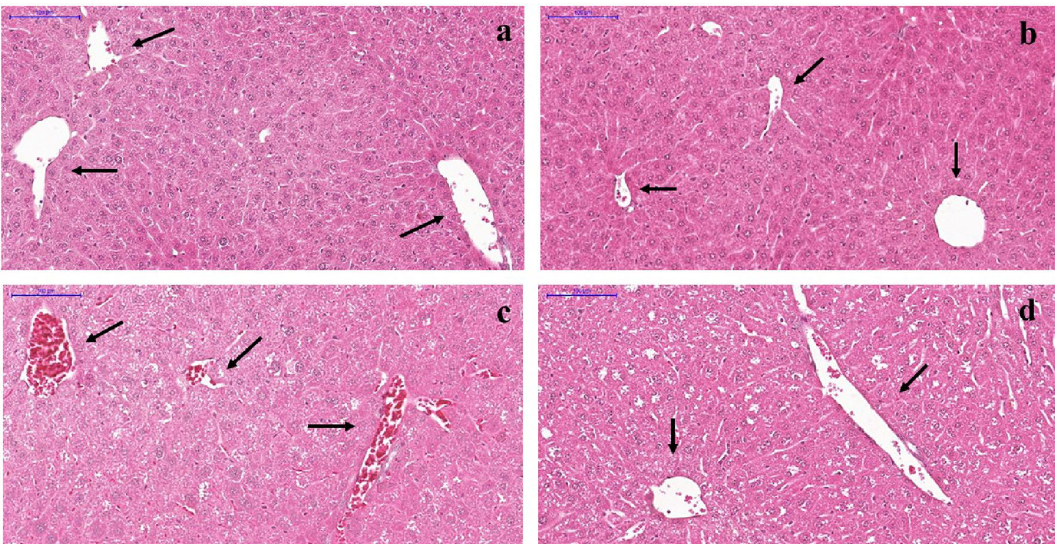
Figure 3. Representative photomicrographs of Hematoxylin & Eosin stained liver from C57BL/6 STZ-induced diabetic mice, + /− Saccharomyces boulardii (0.5 × 10 8 colony-forming units, THT 500,101 strain , Probiotics and Starters Cultures, Belgium) for 8 weeks. Control (a) and control + probiotic (b) show normal hepatocytes organization and hepatic vessels ( → ) with no sign of congestion. Hepatic vessels ( → ) from the diabetic group (c) showed severe congestion while diabetic mice + probiotic (d) showed slight vessel congestion similar to control. Scale bar: 100 μm; 200 × magnification.